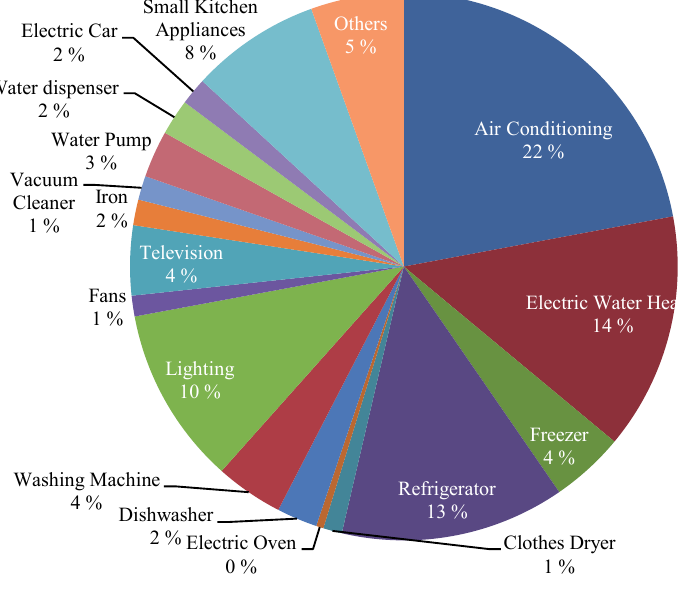
Fig. 2. Actual total annual energy consumption by end-use of appliances in the middle district in